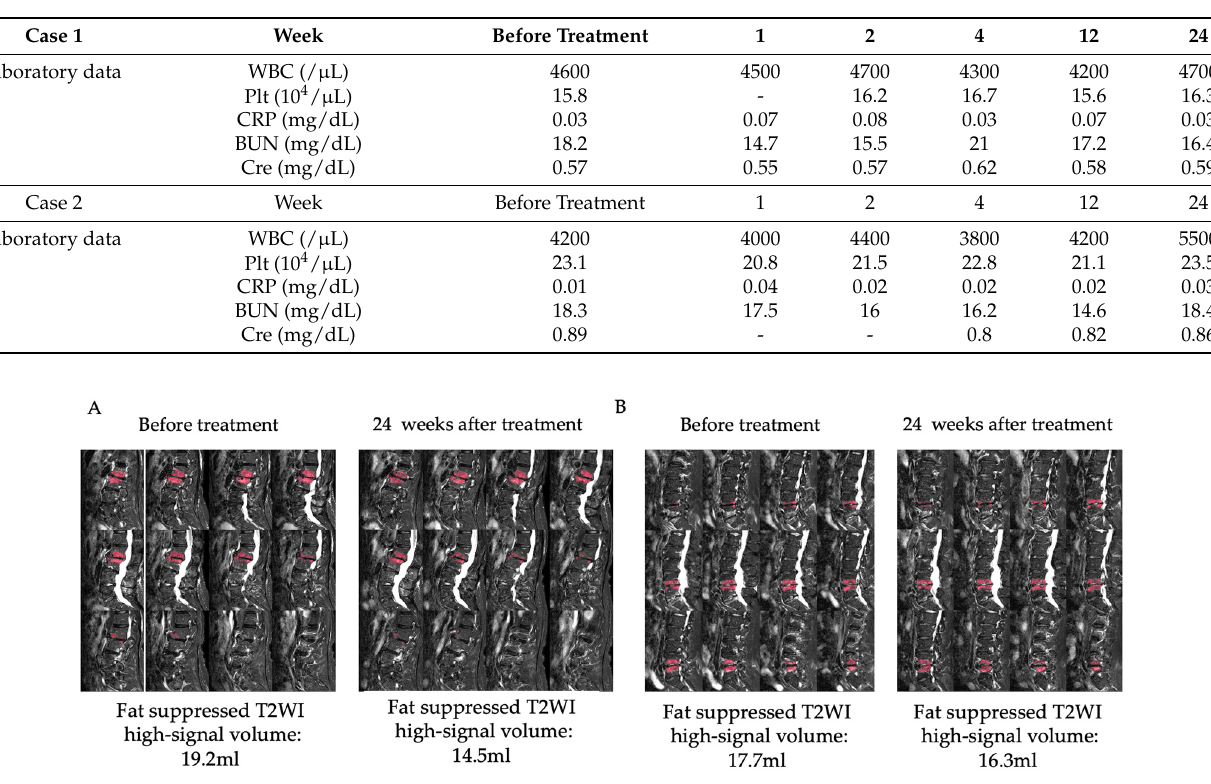
Figure 5. Scores of the VAS, ODI, and RDQ in case 1 and case 2. The VAS, ODI, and RDQ for case 1 and case 2 are shown. After PRP administration, the VAS in case 1 improved temporarily but re- turned to the same level as before administration at the last observation. All other scores in case 1 improved at the last observation compared to the pre-administration level. All scores in case 2 wors- ened temporarily after PRP administration but then gradually improved and eventually became lower than before administration. Table 3. Patient demographics. Variable